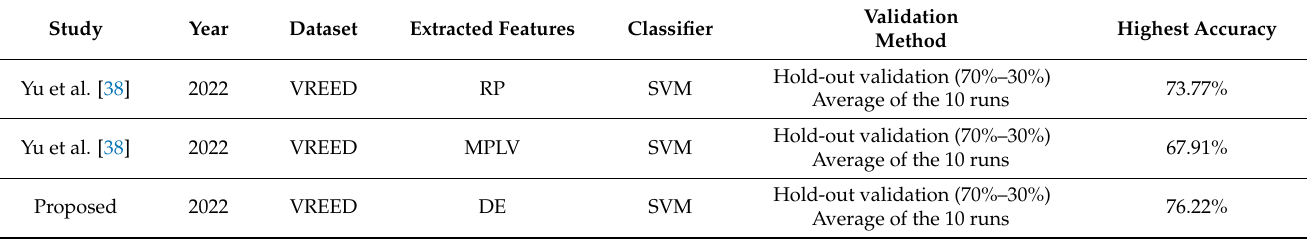
Table 2. Comparison of the proposed approach with the existing approach. The bold case indicates the best accuracy